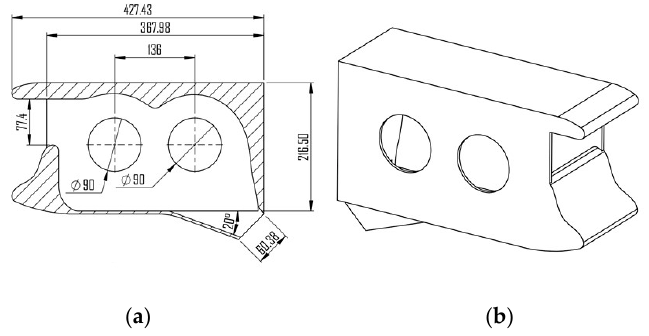
Figure 3. Shroud and baffle plate: ( a ) Dimensions; ( b ) Isometric